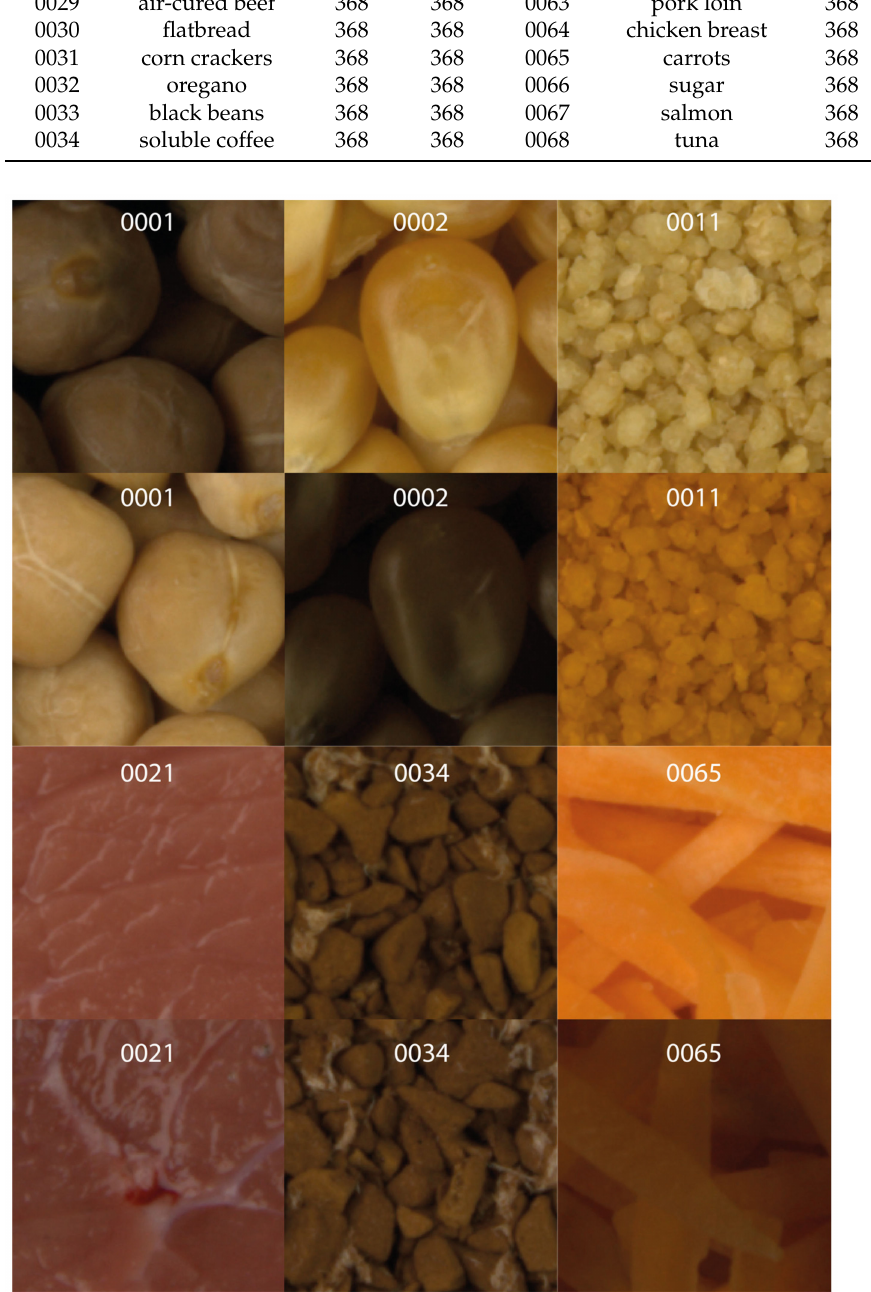
Figure 4. Examples of images in the RawFooT [30] test set and their corresponding labels. Table 3 shows class names and number of samples in the